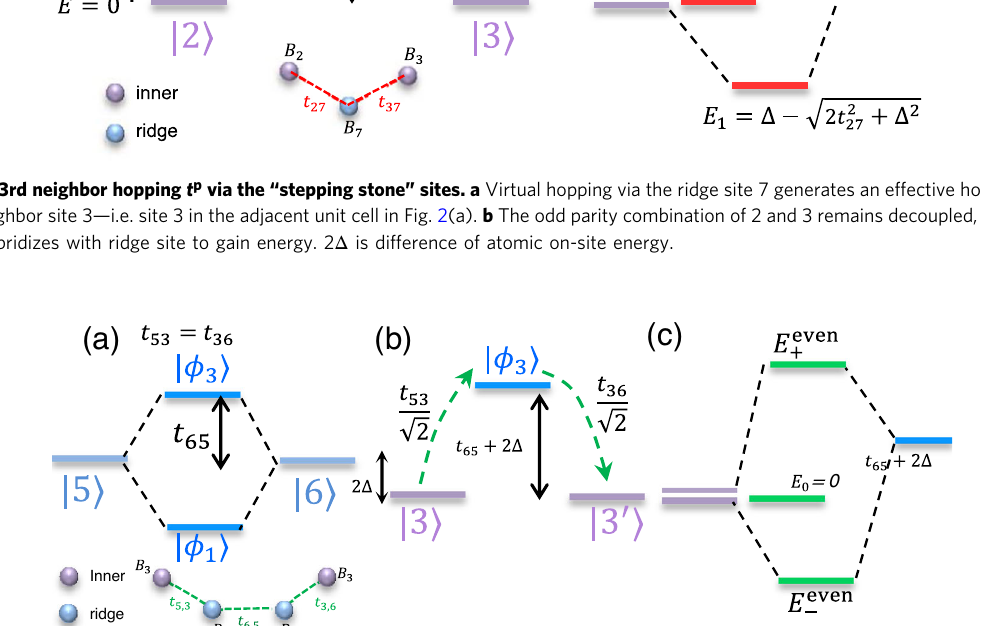
Fig. 4 Effective 2nd neighbor hopping ~ t via “ stepping stone ” sites. a Formation of bonding ϕ and 6. b Effective hopping ~ t between second neighbor inner sites 3 and 3 0 can be formed by virtual hopping via the anti-bonding orbital ϕ atoms. 2 Δ is difference of atomic on-site energy. E 0 is atomic on-site energy of 3 j i and 3 0 molecular states which connect B3 to one of its successive third nearest neighbors through antibonding